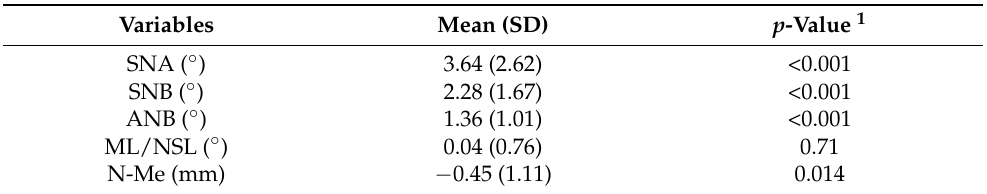
Table 1. Mean (standard deviation) differences between conventional cephalometrics (T2C REF2 ) and